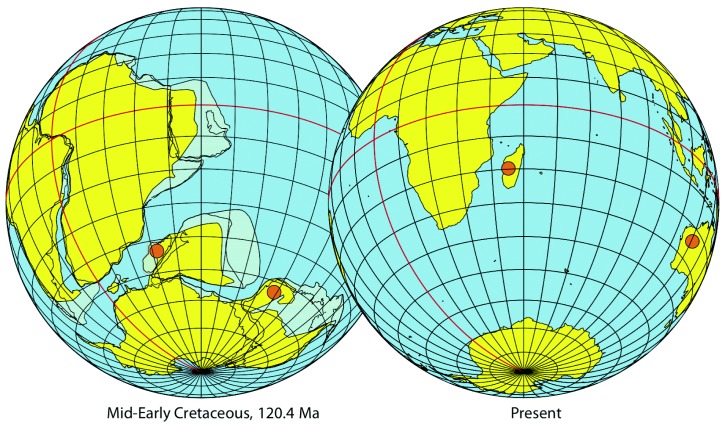
Maps showing the Gondwana continents in the mid-Early Cretaceous (left) and at present (right), with orange dots showing the current localities of Typhleotris (Madagascar) and Milyeringa (Australia).